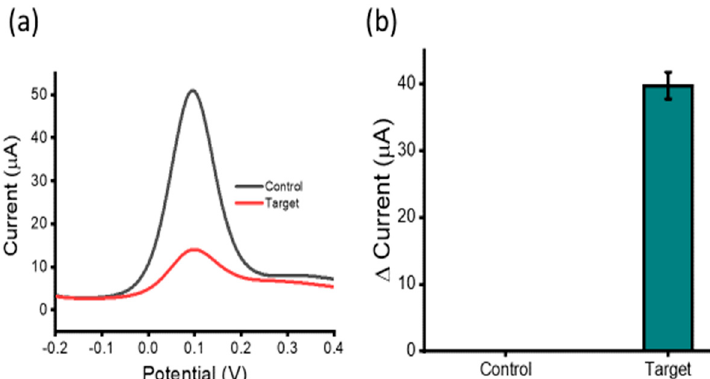
Figure 2. Assay functionality: Differential pulse voltammetry (DPV) readout depicting current responses for 100 nM synthetic HOTAIR lncRNA target and NoT ( a , b ) illustrating the change in current observed between the HOTAIR targets and control. Error bars represent the relative standard deviation across three repeated experiments.